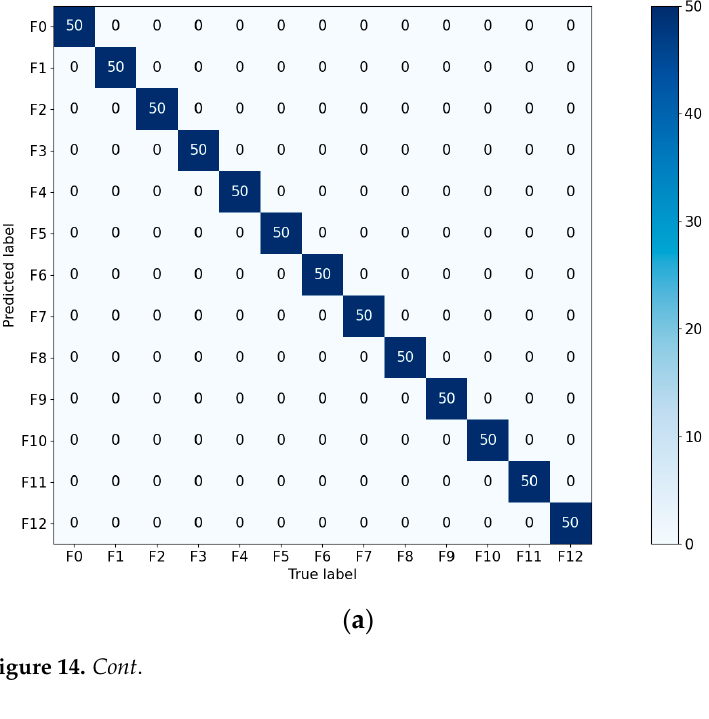
Figure 13. Dimensionality reduction visualisation of CSTV filter circuit responses based on t-SNE. ( a ) Visualisation of the original response signal; and ( b ) visualisation of features extracted by Model optima .